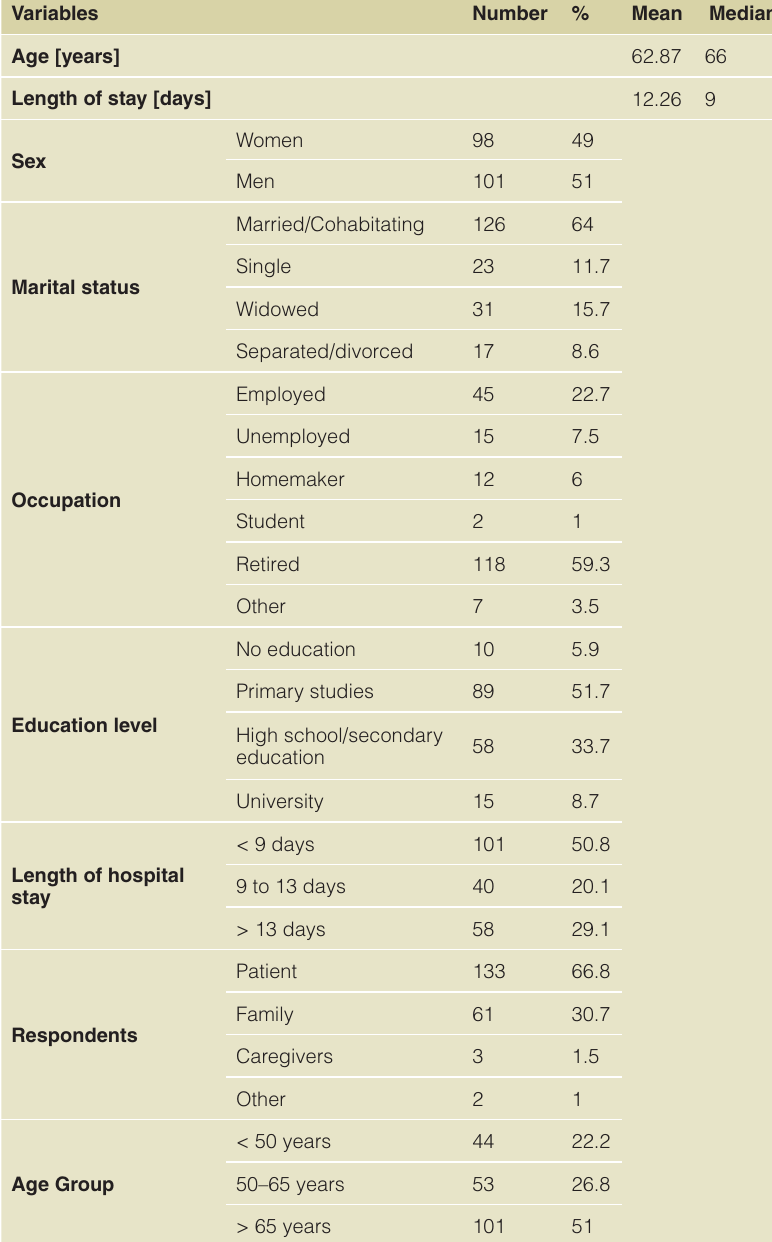
Table 1. Sociodemographic data of the